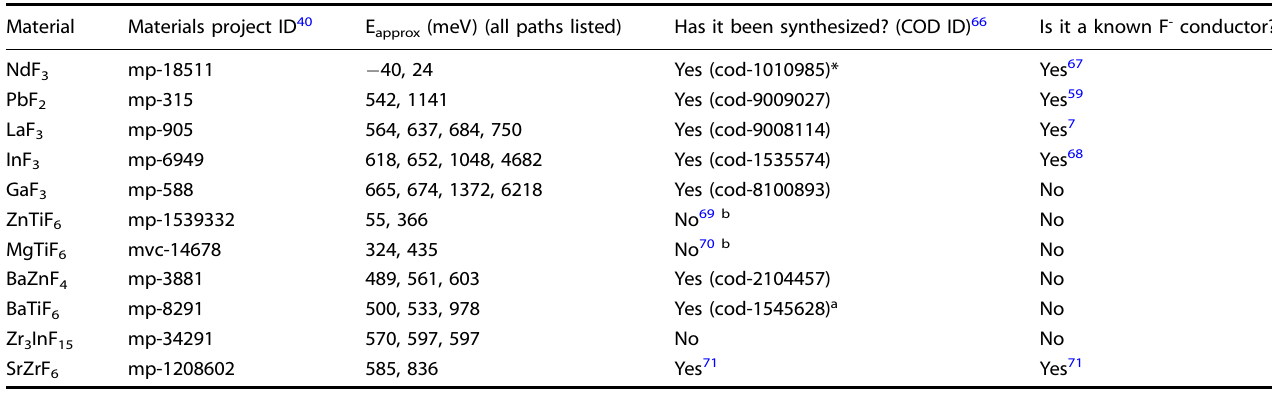
Table 2. Candidate materials for cost-effective solid-state